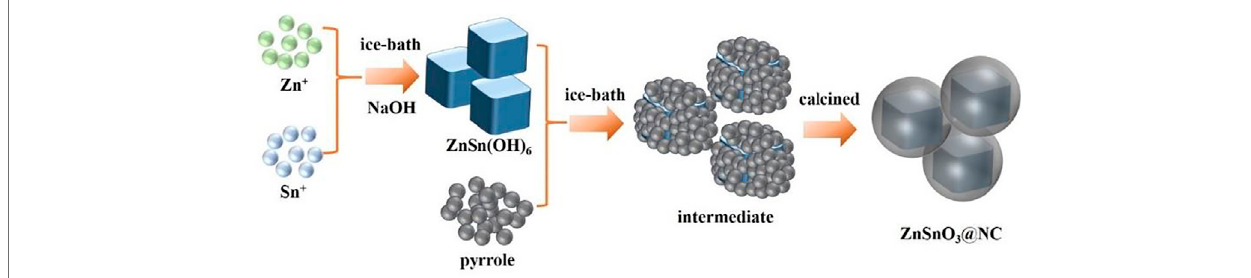
FIGURE 1 | Schematic illustration of the synthesis process of ZSO@NC.